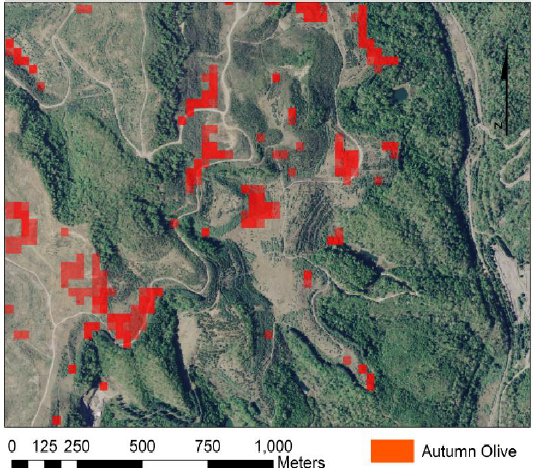
Figure 6. Classified areas of autumn olive in red are in fair agreement with autumn olive on the landscape in the linear SVM